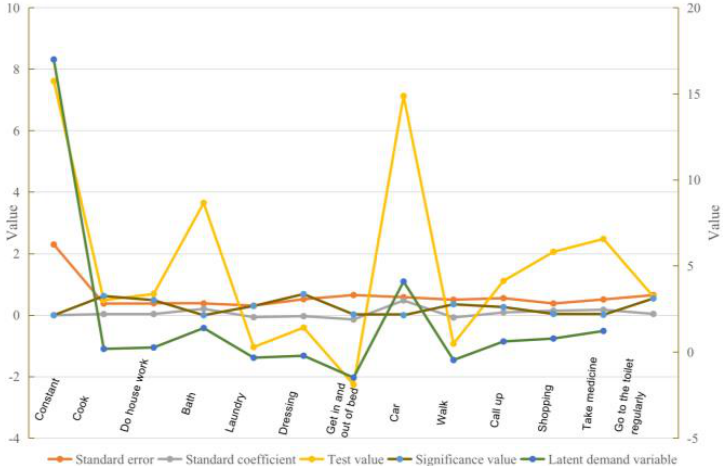
Figure 5. Influence of daily living ability on the demand for senior care services.